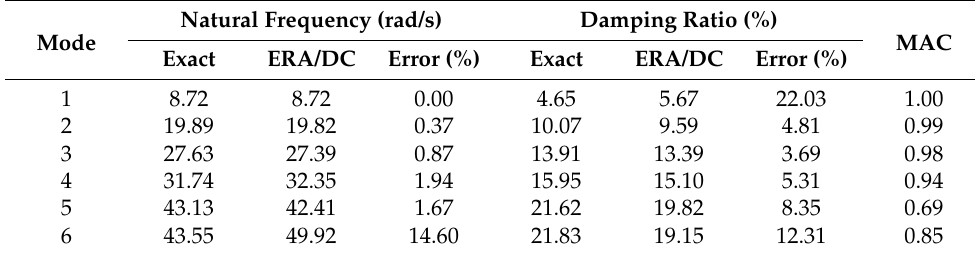
Figure 10. Mode shapes of six-DOF chain model with heavy damping (the solid line is an analytic solution, the dotted line is ERA/DC identification result). 3.3. Seven-DOF Car Model To demonstrate this method applicable to complex structure systems, a car model with two groups of closely spaced modes is considered, as shown in Figure 11. The system is a seven-DOF system, including car body bounce, pitch, and roll. Each of the four wheels represents a DOF and has the dynamic behavior of bounce; related parameters are shown in Table 3. The mass matrix 𝑀 , stiffness matrix 𝐾 , and damping matrix 𝐶 of the system are expressed as follows.